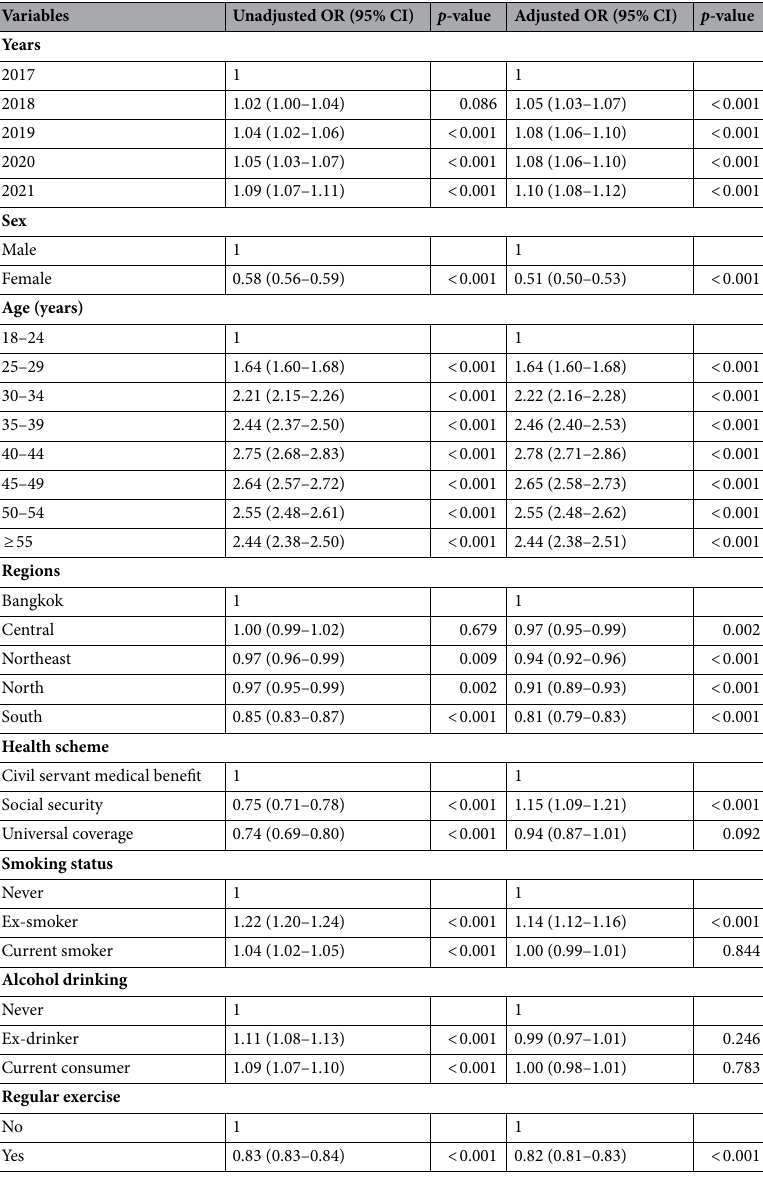
Table 3. Univariable and multivariable analysis of the association between demographic and behavioral factors and obesity prevalence among RTA personnel (2017–2021). OR odds ratio, CI confidence